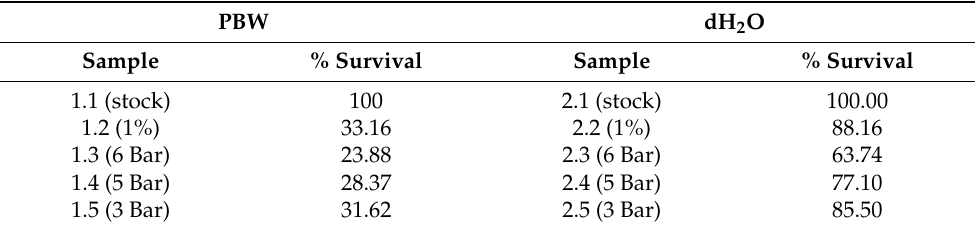
Table 3. PGS concentrations summarized in the form of calculated % survival.